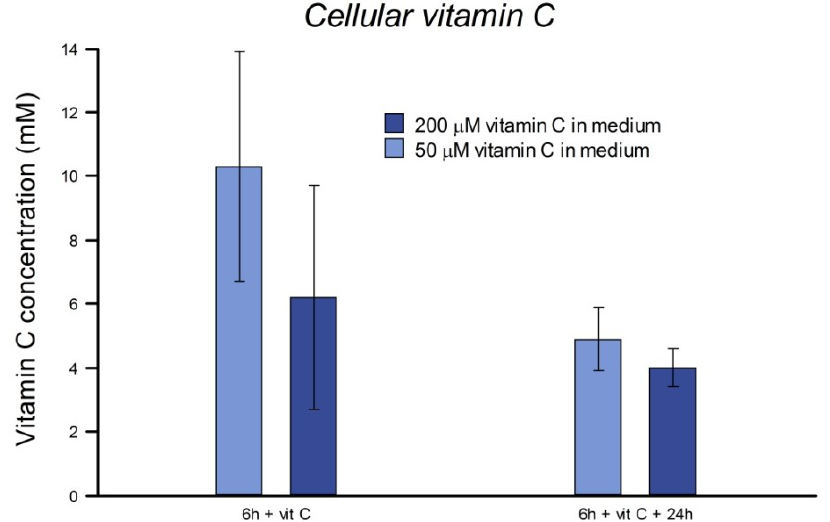
Figure 7. Uptake of vitamin C by HeLa cells. Cells were incubated for 6 h in medium containing vitamin C at 50 µM (light shading) or 200 µM (dark shading). Intracellular vitamin C was measured by HPLC at the end of this incubation or after a further 24 h